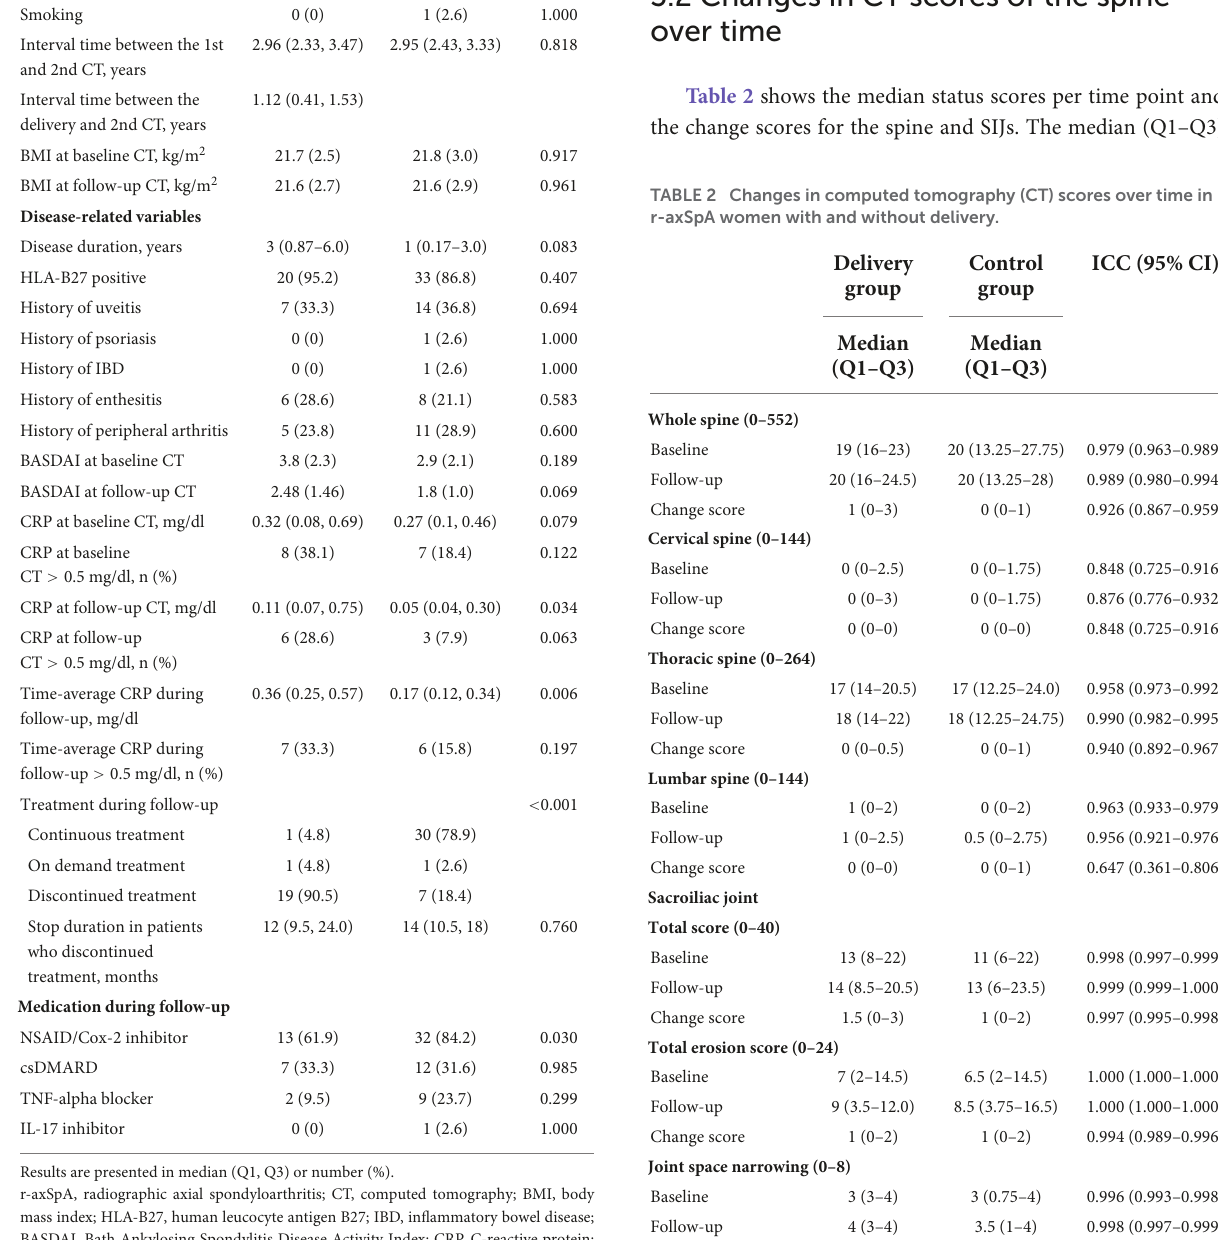
the change scores for the spine and SIJs. The median (Q1–Q3)